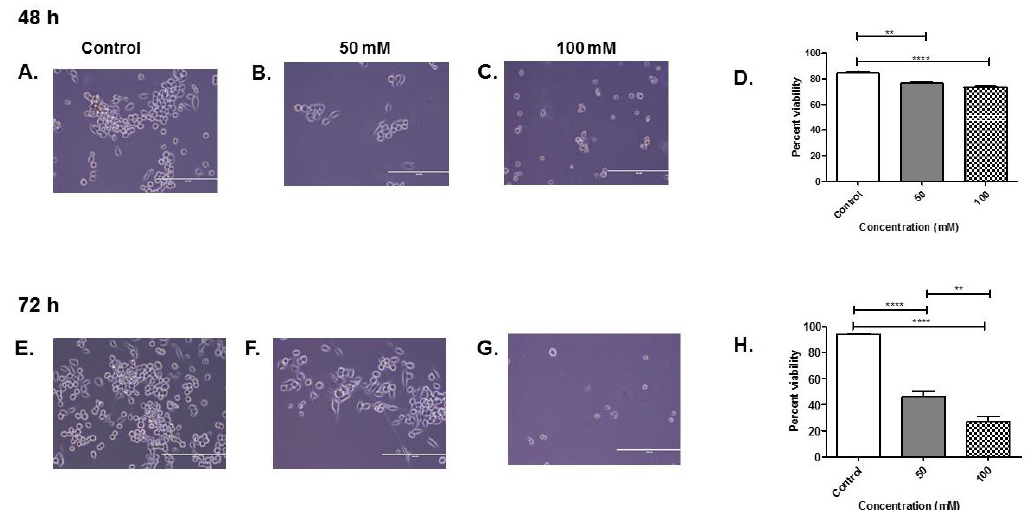
Figure 1. Effects of EtOH on microglial cell line BV-2 cells. BV-2 cells were treated with ETOH for ( A – C ) 48 or ( E – G ) 72 h. ( D , H ) At 48 and 72 h, EtOH administration of cell viability was assessed